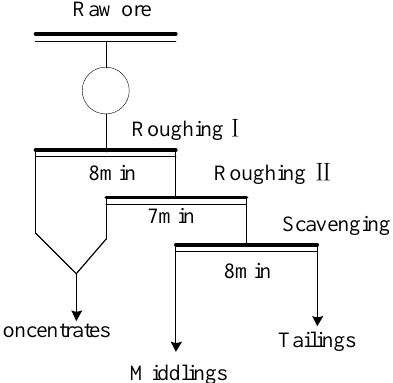
Figure 2. Flow chart of the two roughing-one scavenging mineral processing.